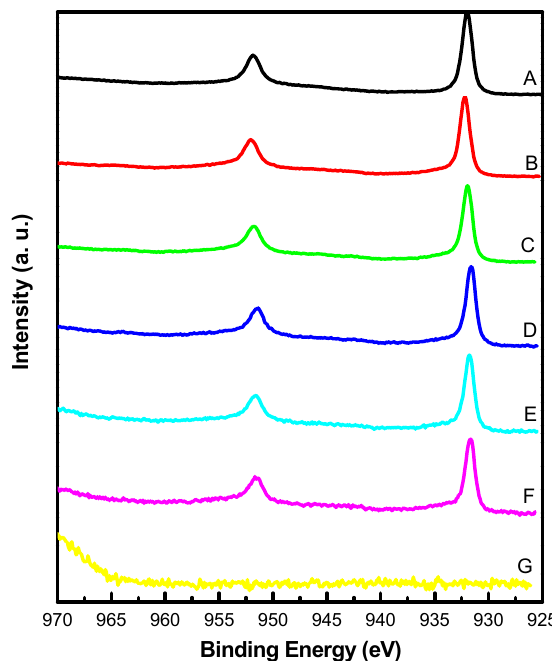
Figure 4. Cu 2p peaks of co-bioleaching chalcopyrite and bornite (ratio of Ccp/Bn was 3:1). ( A ) bornite, ( B ) chalcopyrite, ( C ) 5 days, ( D ) 10 days, ( E ) 15 days, ( F ) 23 days, ( G ) 30 days. The copper Auger spectra (Cu LMM) excited with X-rays and the atomic percentages of Cu 2p